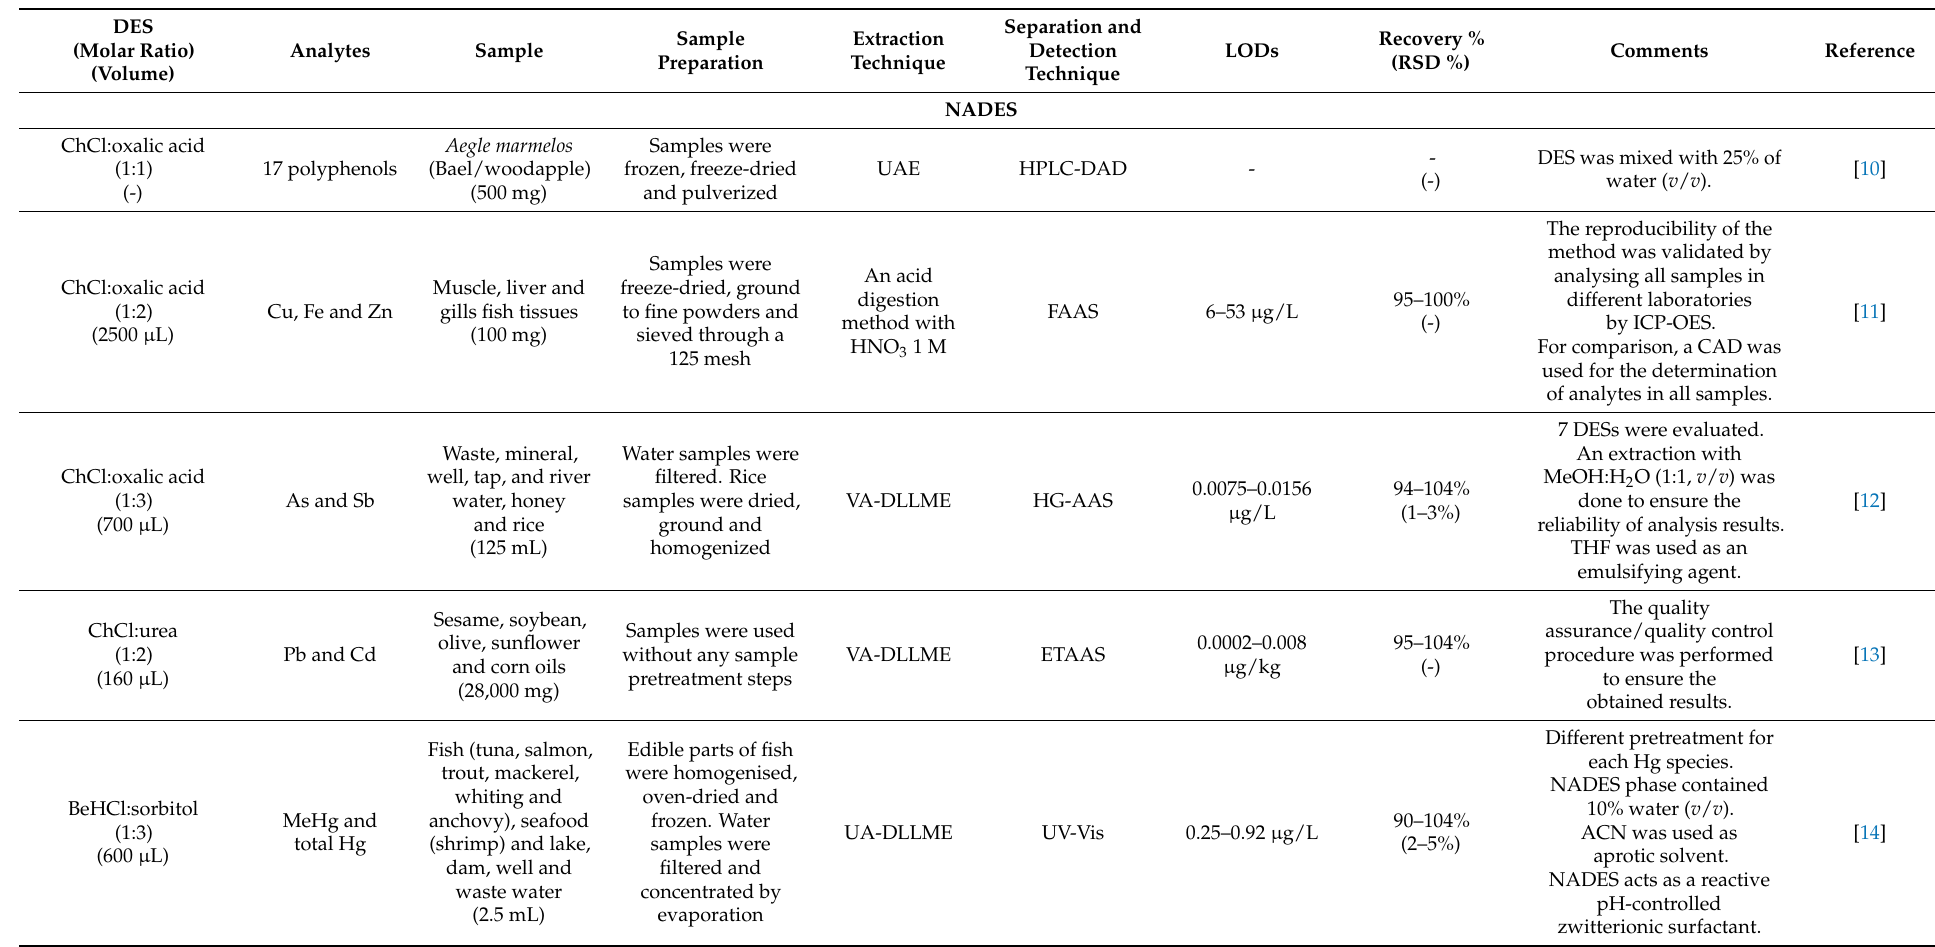
Table 1. Application of hydrophilic DESs in sample preparation procedures for food